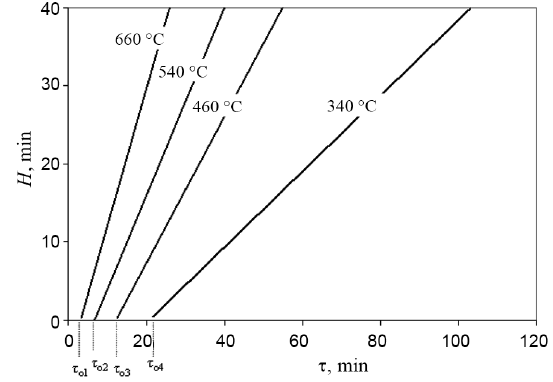
Fig. 2. The dependence between wood charring depth H and the combustion time τ at medium temperatures (Taubkin 1999)